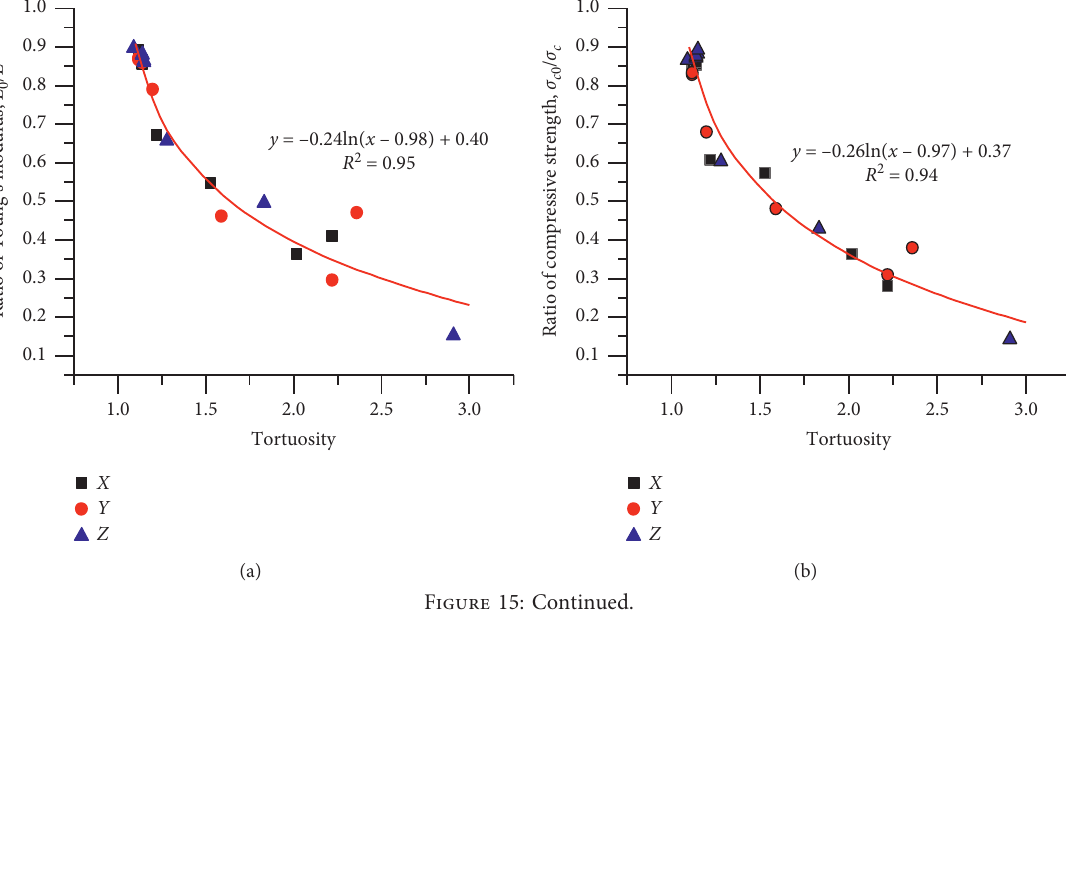
y = –0.24ln( x – 0.98) + 0.40 R 2 =